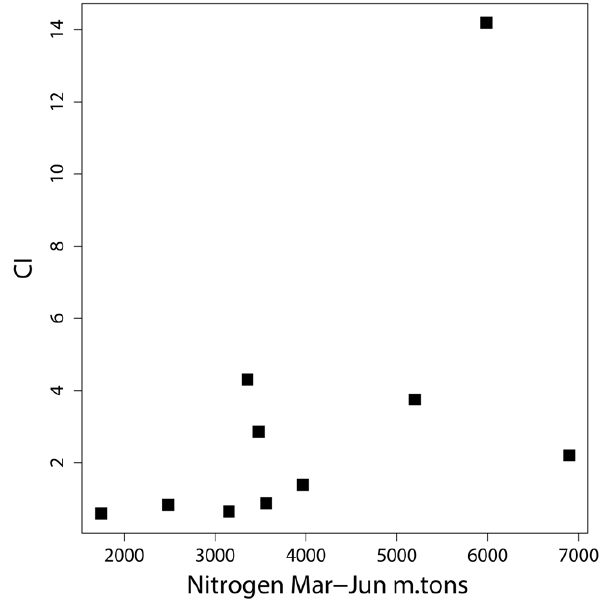
Figure 7. Spring (March to June) load of NOx nitrogen compared to CI showing the lack of a relationship (r 2 =0.29, p=0.11).